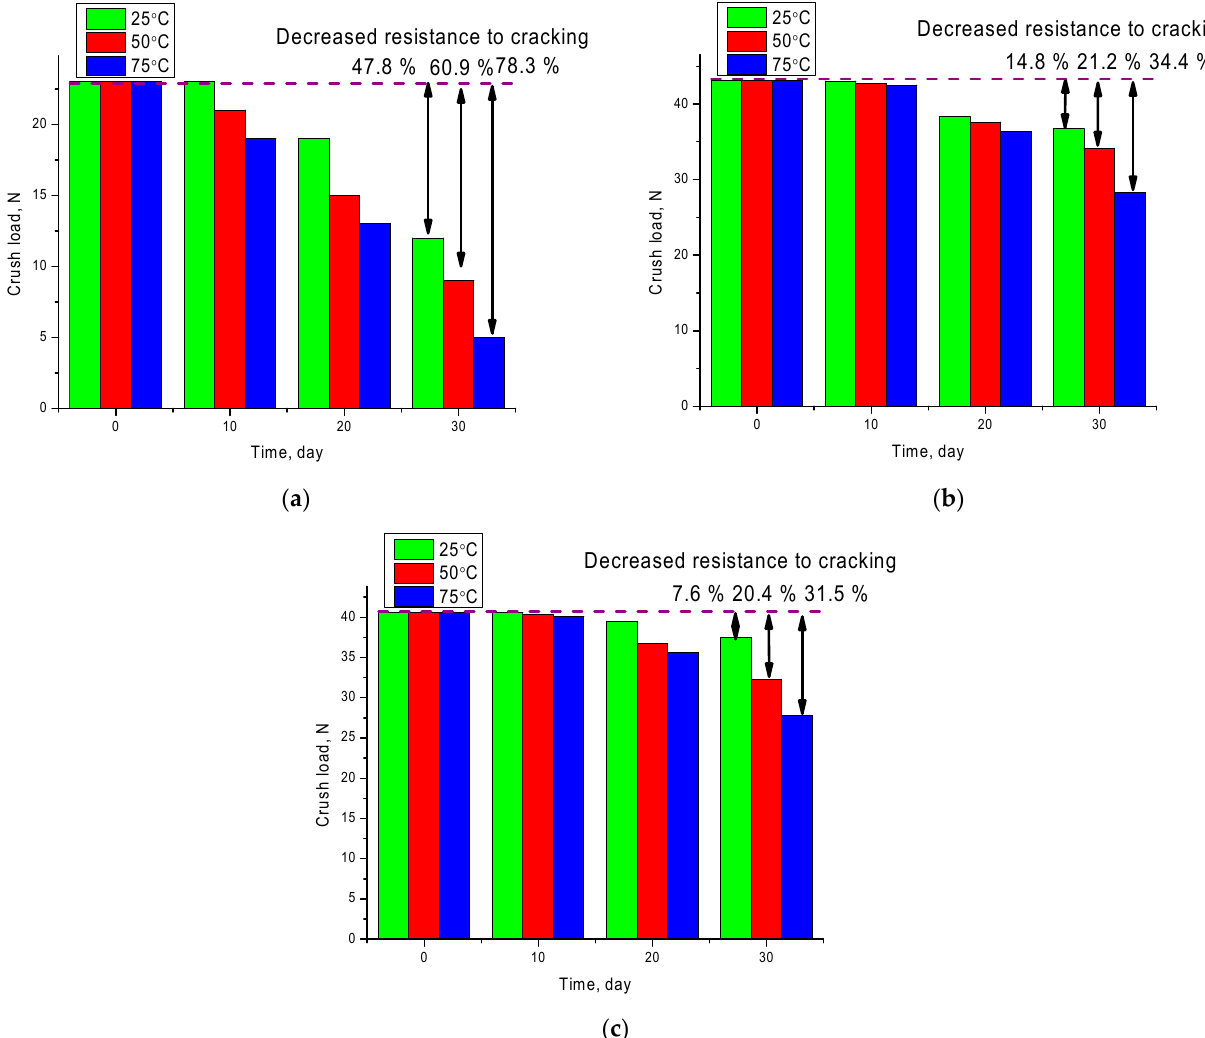
Figure 9. Graph of changes in ceramics fracture resistance: ( a ) LTO-1; ( b ) LTO-2; ( c ) LTO-3. According to the data obtained, corrosion processes accompanied by mass loss and deformation of the crystal structure lead to a sharp decrease in ceramics resistance to cracking and destruction. In this case, the maximum decrease in fracture toughness for LTO-1 samples was from 47 to 78%, depending on the solution temperature. For two-phase samples LTO-2 and LTO-3, the maximum decrease in resistance to cracking and fracture was no more than 32%, which is more than 1.5–2 times less than similar indicators for LTO-1 samples. At the same time, in the case of the LTO-3 sample, when it was in an environment at a temperature of 25 °C, the maximum decrease in the re- sistance value was no more than 8%, which indicates a high degree of ceramics re- sistance to degradation and destruction as a result of external pressure forces. Thus, summarizing all of the above, we can conclude that the formation of two-phase LiTiO 2 -Li 2 TiO 3 ceramics with a cubic phase content of no more than 10–20% can significantly increase both the strength properties of ceramics and increase the re- sistance to degradation and corrosion, as well as reduce the oxidation and destruction rate of ceramics. The results obtained are also in good agreement with other works [9–14] devoted to studying the effect of two phases on the stability of lithium-containing ceramics and increasing the efficiency of their productivity.